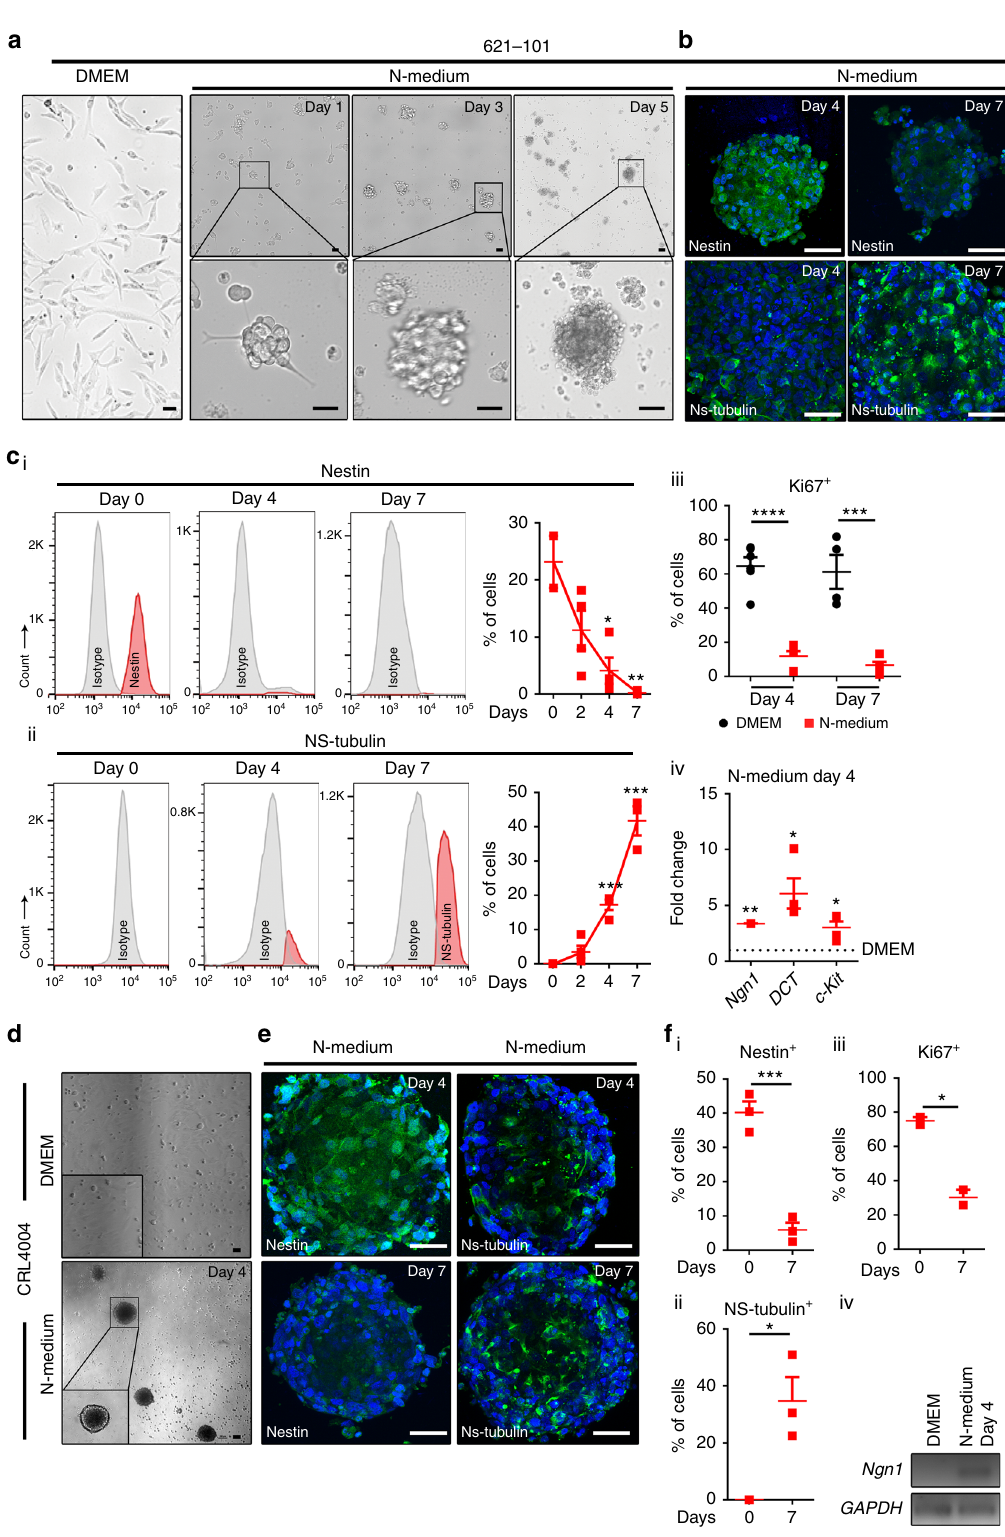
Fig. 3 Neuronal differentiation of angiomyolipoma cells. a , d Bright fi eld images of a 621 – 101 and d CRL4004 cells in DMEM or N-medium. b , e Nestin and NS-tubulin in b 621 – 101 and e CRL4004 sphere-like structures in N-medium at day 4 and day 7 by immuno fl uorescence. c , f FACS of c 621 – 101 and f CRL4004 cells in N-medium. c , f Representative histograms and graphs showing percentages of cells in N-medium expressing ( c (i), f (i)) nestin only and ( c (ii), f (ii)) NS-tubulin only. c (iii), f (iii) Ki-67 in ( c (iii)) 621 – 101 and ( f (iii)) CRL4004 cells in N-medium vs. DMEM at days 4 and 7. c (iv), f (iv) q(RT)-PCR of Ngn1 , DCT , and c-Kit mRNA relative to GAPDH in c (iv) 621 – 101 or f (iv) CRL4004 cells in N-medium vs. DMEM at day 4. Data represent means ± s.e.m. Error bars are de fi ned as means + s.e.m. * P ≤ 0.05, ** P ≤ 0.01, *** P ≤ 0.001, **** P ≤ 0.0001 by t -test. Data are representative of two ( b , e ), three, n = 3 ( f (i – iv), c (iv)), four ( d ); n = 4 ( c (i – iii)), and seven ( a ) independent experiments